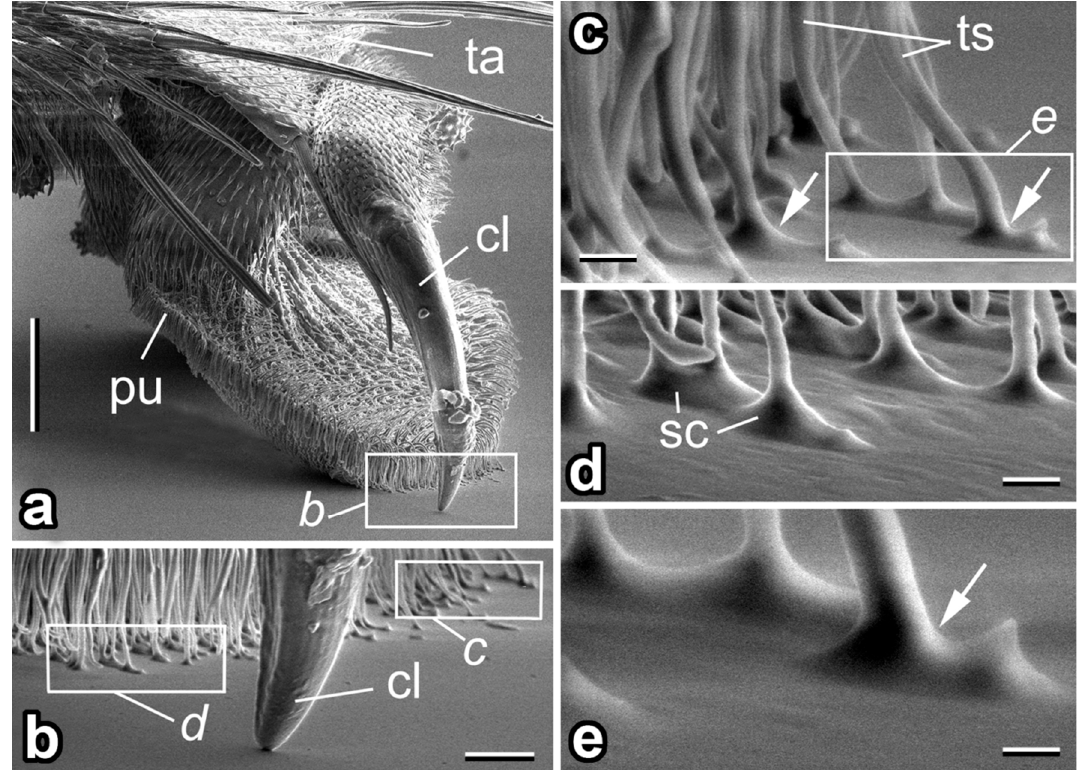
Figure 2. The attachment system of the fly Eristalis tenax (cryo-SEM). ( a ) Dorso-lateral view of the distal part of the tarsus (ta) with pretarsus bearing claws (cl) and pulvilli (pu). ( b ) The claw (cl) and distal portion of the pulvillus in contact with a smooth substrate. ( c – e ) Tenent setae (ts) covering the pulvillus in contact with the substrate. Note the pad secretion (sc) delivered into a contact zone. Arrows in ( c , e ) show examples of the setal terminal elements, spatulae, in contact. Scale bars: 100 µm ( a ),10 µm ( b ), 2 µm ( c , d ), 1 µm ( e ).